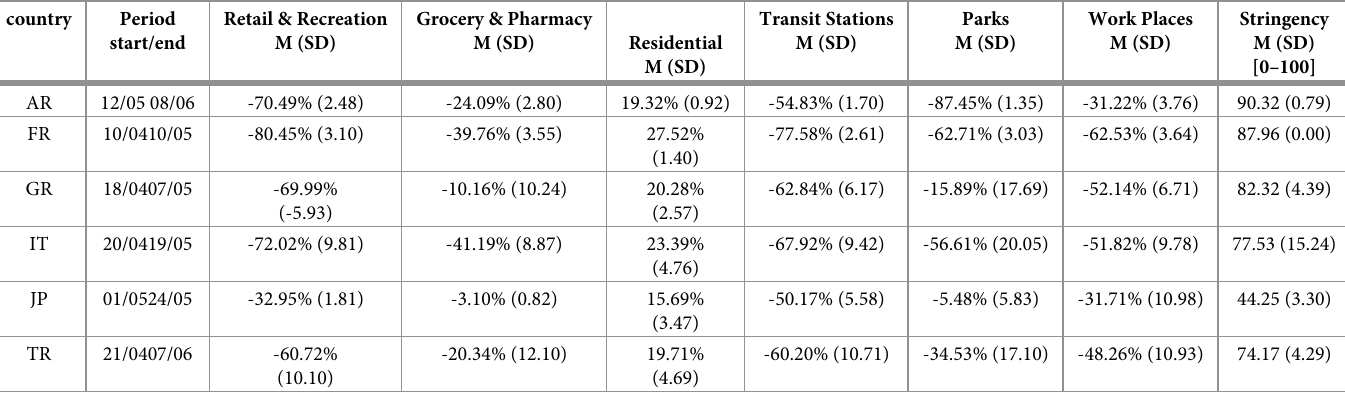
Table 2. Mobility changes and stringency indices during the assessment period by countries and areas.